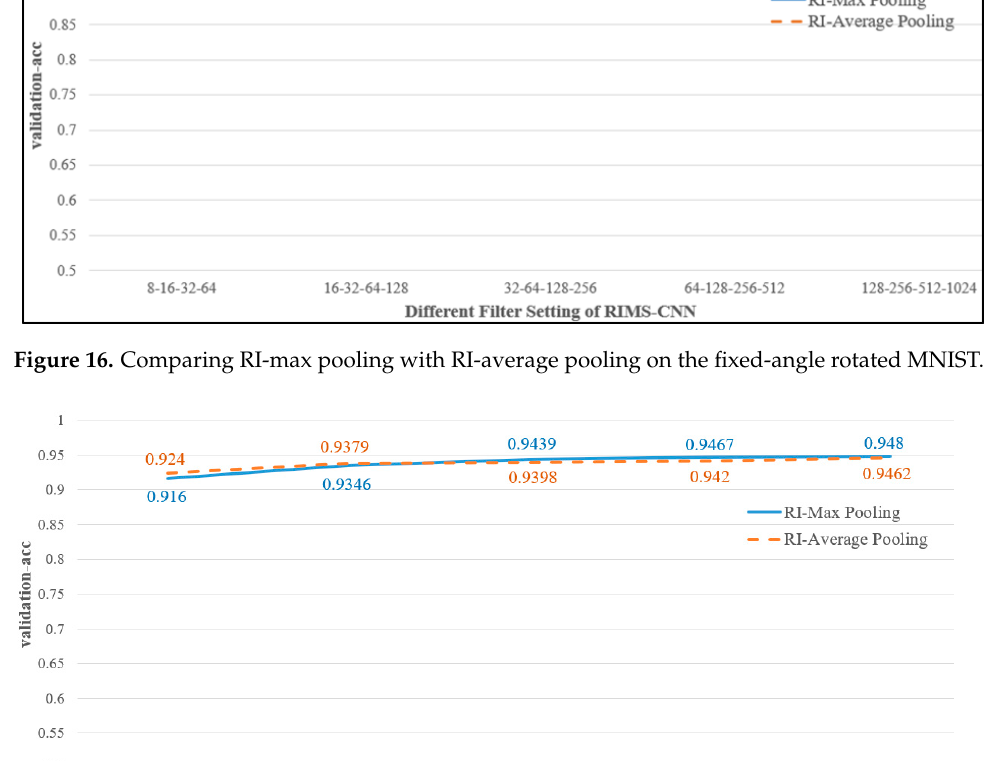
Figure 17. Comparing RI-max pooling with RI-average pooling on the fixed-angle rotated FASH- ION-MNIST.